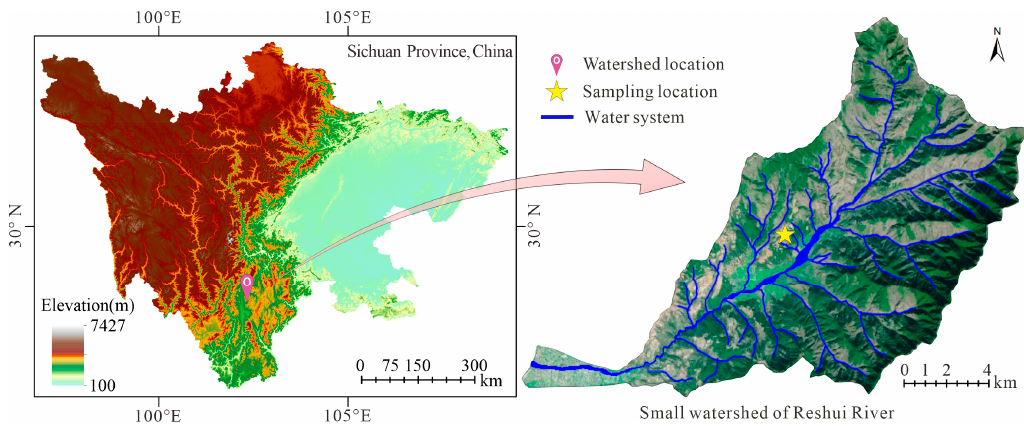
Figure 1. Study area and sampling location of soil material in physical model experiment.